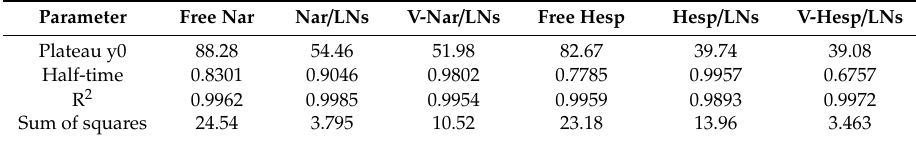
Table 3. Parameters for polyphenol release data fitted with one phase exponential nonlinear